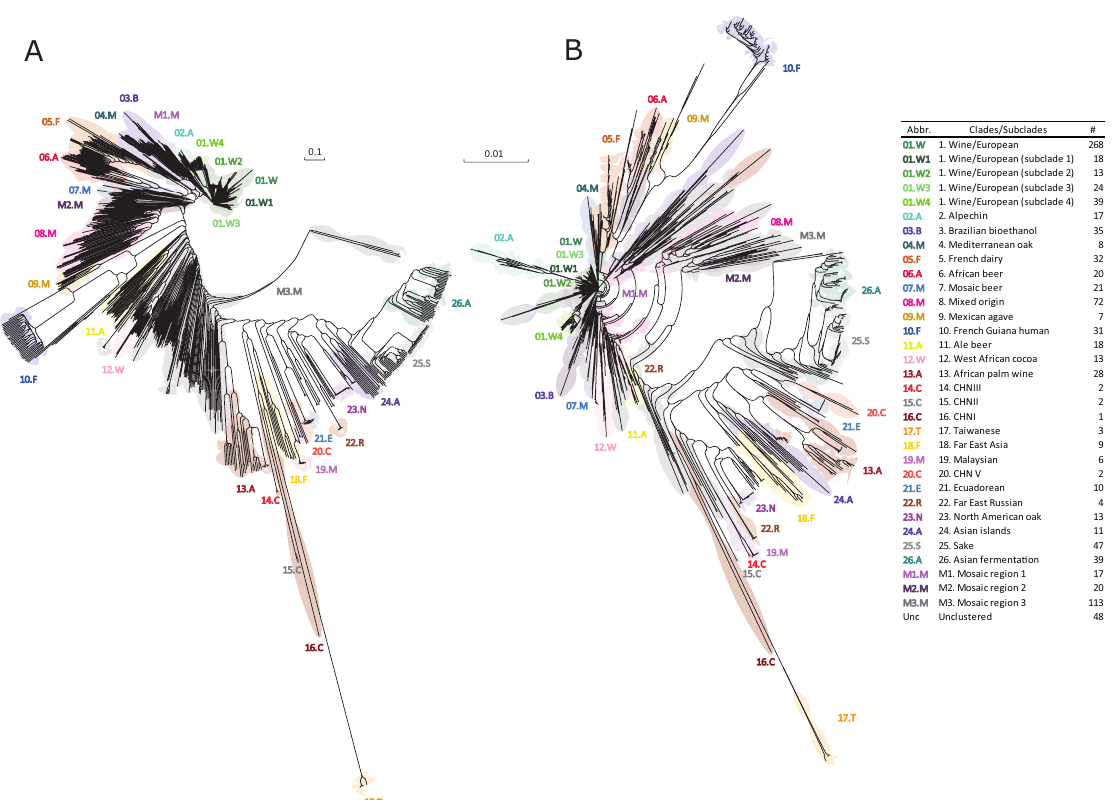
Figure 1. Population structure of S. cerevisiae obtained with total and partial genomic information. ( A ) Neighbor-joining tree described by [21] using the whole genome sequencing information of 1011 yeast strains. This tree was considered as the Reference (REF) tree. ( B ) Neighbor-joining tree obtained with the concatenated information of the 22 selected genes in 1011 yeast strains. This tree was considered as the Total Evidence (TE) tree. In both trees the phylogenetic clusters and subclusters are represented by the same colour